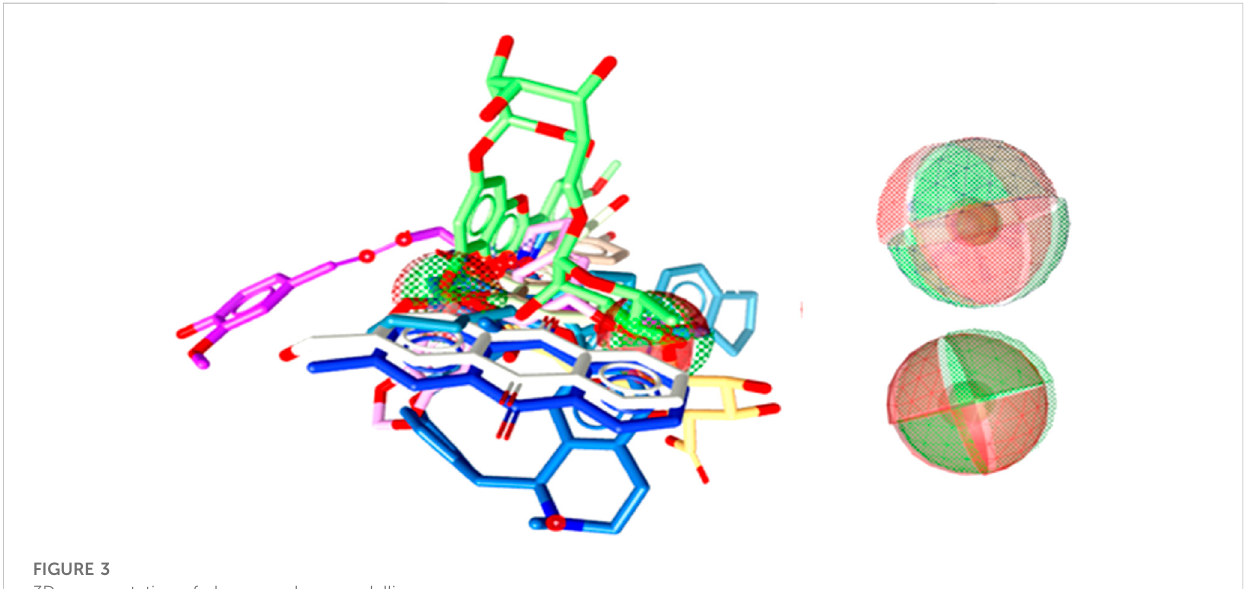
FIGURE 3 3D representation of pharmacophore